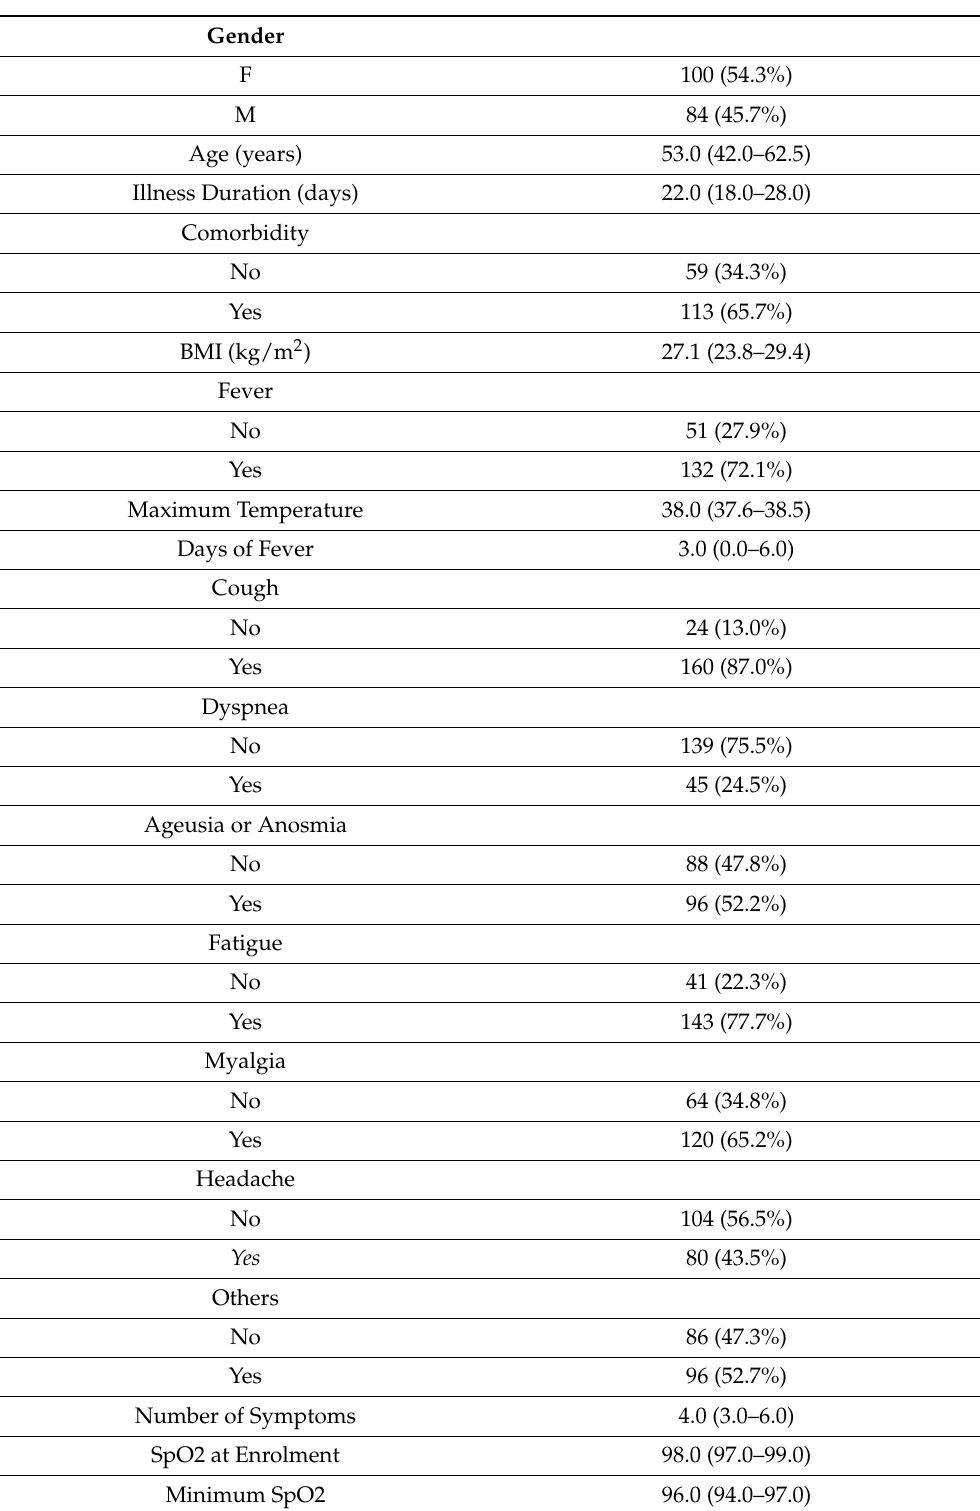
Table 1. The patients’ socio-demographic and clinical characteristics ( n =